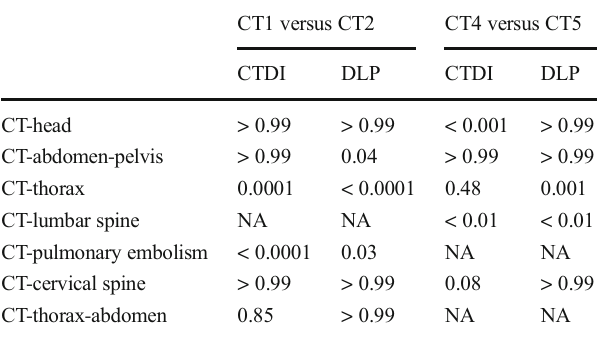
Multiple comparison adjusted p values for comparison of median CTDI vol and DLP values between scanners highlighting the intrahospital benchmarking CT1 versus CT2